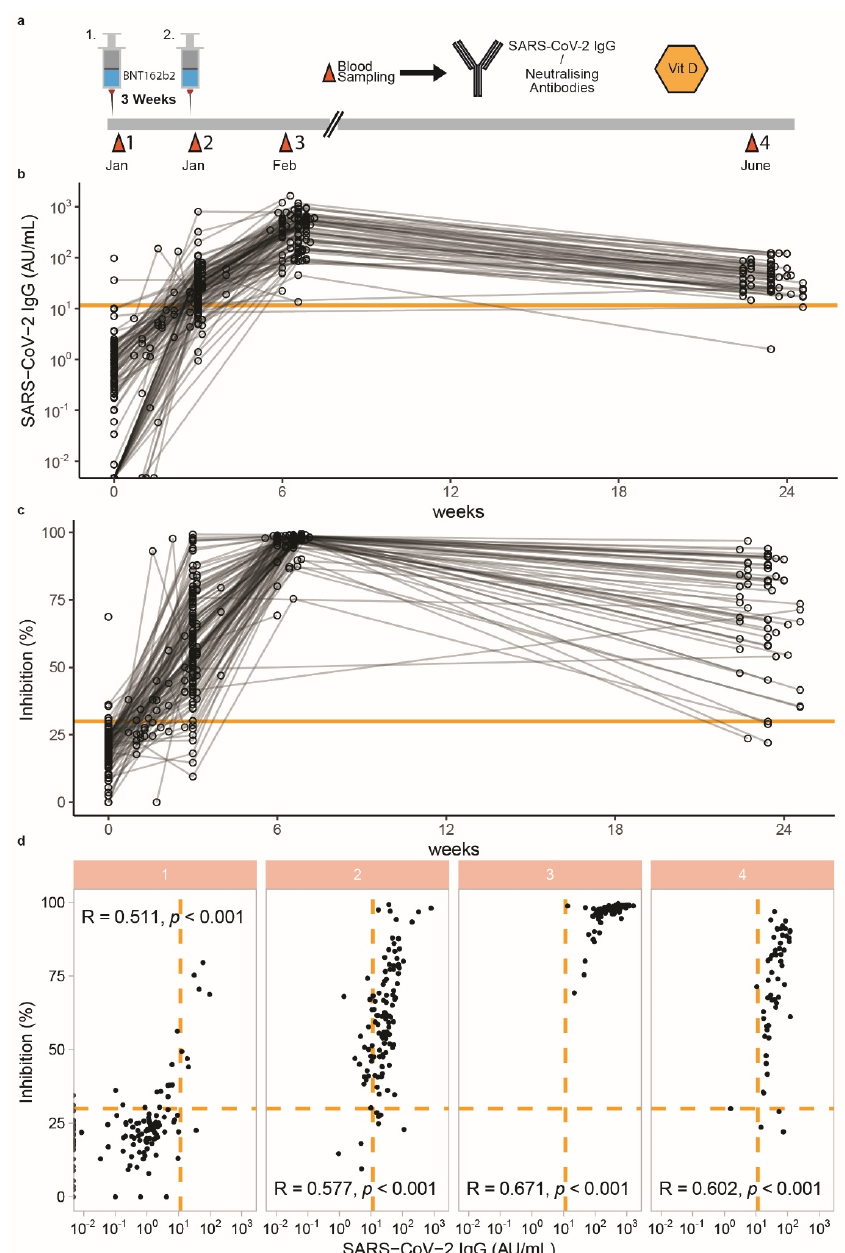
Figure 1. SARS-CoV-2 IgG and neutralising antibody response over 24 weeks in health care workers vaccinated with BNT162b2 vaccine. ( a ) Schematic presentation of the study design. 126 health care workers enrolled in the present study received two BNT162b2 vaccines, second dose followed 3 weeks after the first one. Blood sampling was conducted for each participant at each dose. Blood was also collected three and 21 weeks after the second dose. ( b ) At enrolment, almost all participants were seronegative, with titres below the cut-off of 11.5 AU/mL, and 35 patients had no measurable IgG at baseline. IgG titres were highest at 3 weeks after the second dose, and showed a declining trend towards the 24 week time point. ( c ) Almost all participants had no detectable neutralising antibodies at baseline, with titres below the cut-off of 30% inhibition. Inhibition of spike protein-ACE2 binding was highest at 3 weeks after the second dose and showed a declining trend towards the 24 week time point. ( d ) Spearman’s correlation of SARS-CoV-2 IgG and inhibition activity of the antibodies was assessed at each sampling time point. Both parameters are significantly correlated at all times (R and p values indicated). At the third sampling, the correlation was most prominent, with Spearman’s R =